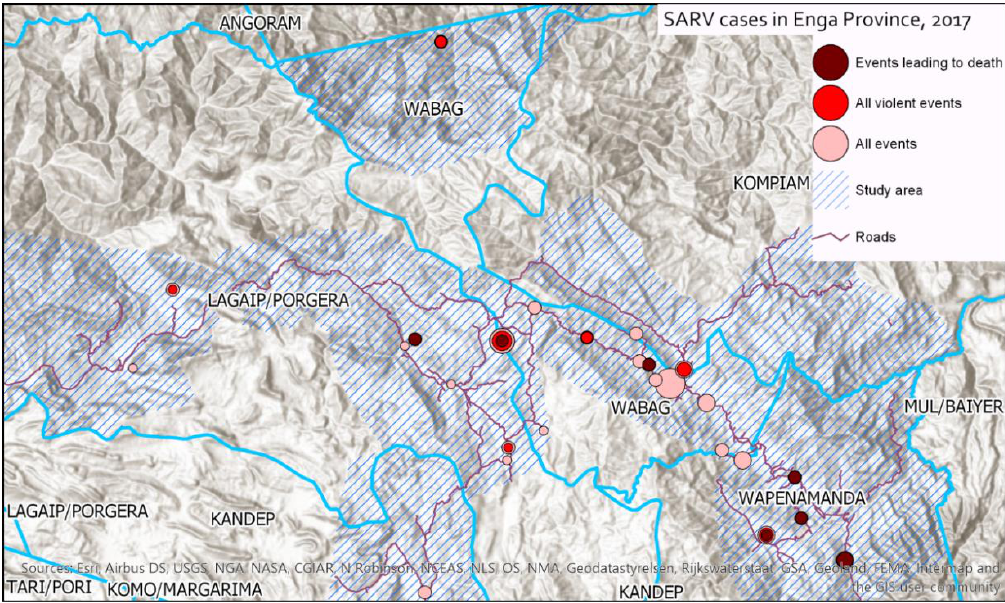
Figure 2: SARV cases in Enga Province,